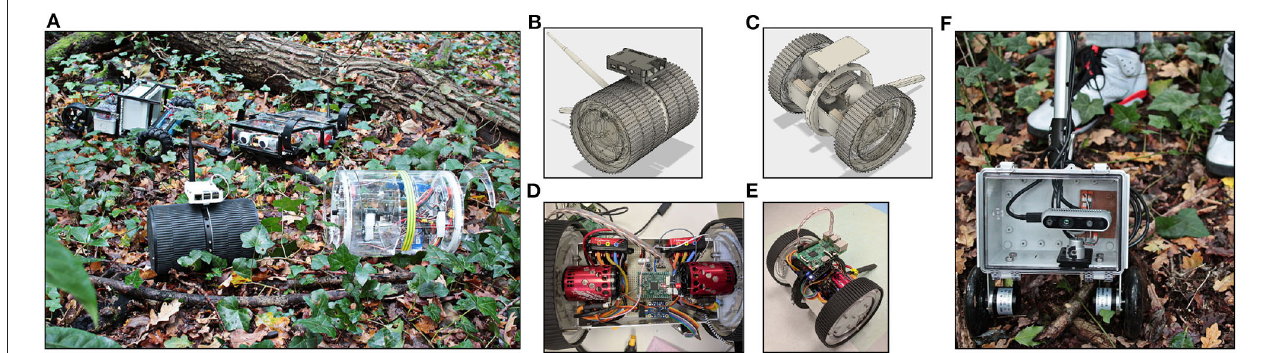
FIGURE 2 | Hardware platforms for the forest environment. Aside from four-/six-wheel drive, and tracks, other locomotion concepts are also investigated for their suitability on forest ground (A) . The torque available to platforms with brushless motors (e.g., B–E ) is helpful for tackling the ubiquitous small obstacles typical for this environment. Additional data for computer vision development is collected with a manual rig (F) . Depth and color images are recorded with a global shutter camera (D435i, www.intel.com) to a laptop in a backpack. Meta data is collected from the camera’s inertial measurement unit, rotary encoders on the wheels, and a GPS. A mobile phone mounted on the telescopic push rod gives remote access to the laptop.